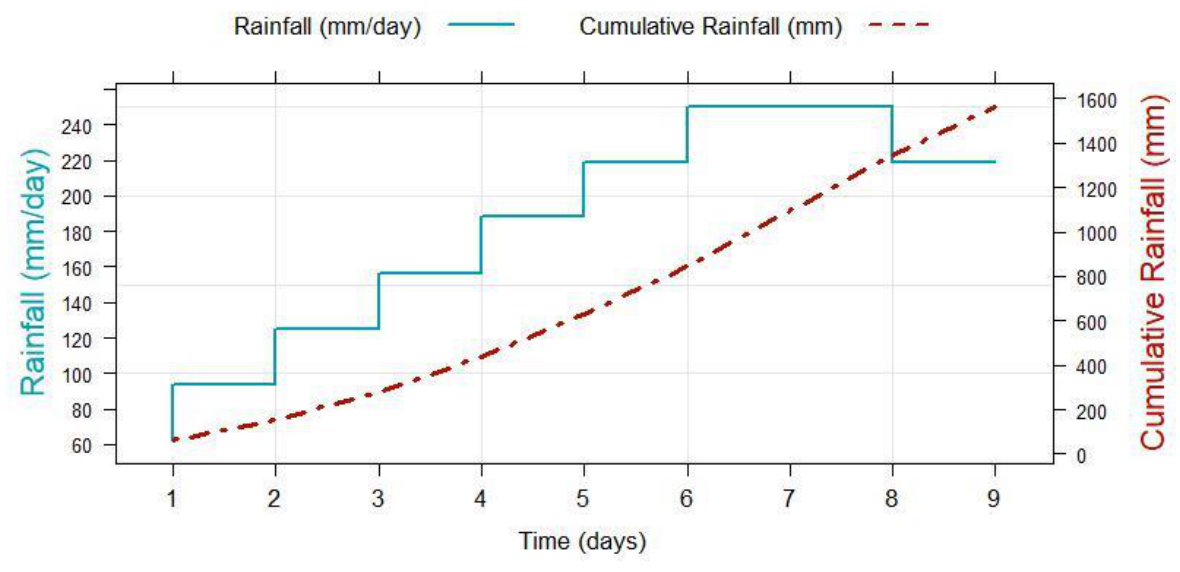
Figure 5. Time-varying rainfall rate prepared for the present study by considering CWC and GPM- IMERG data sets.